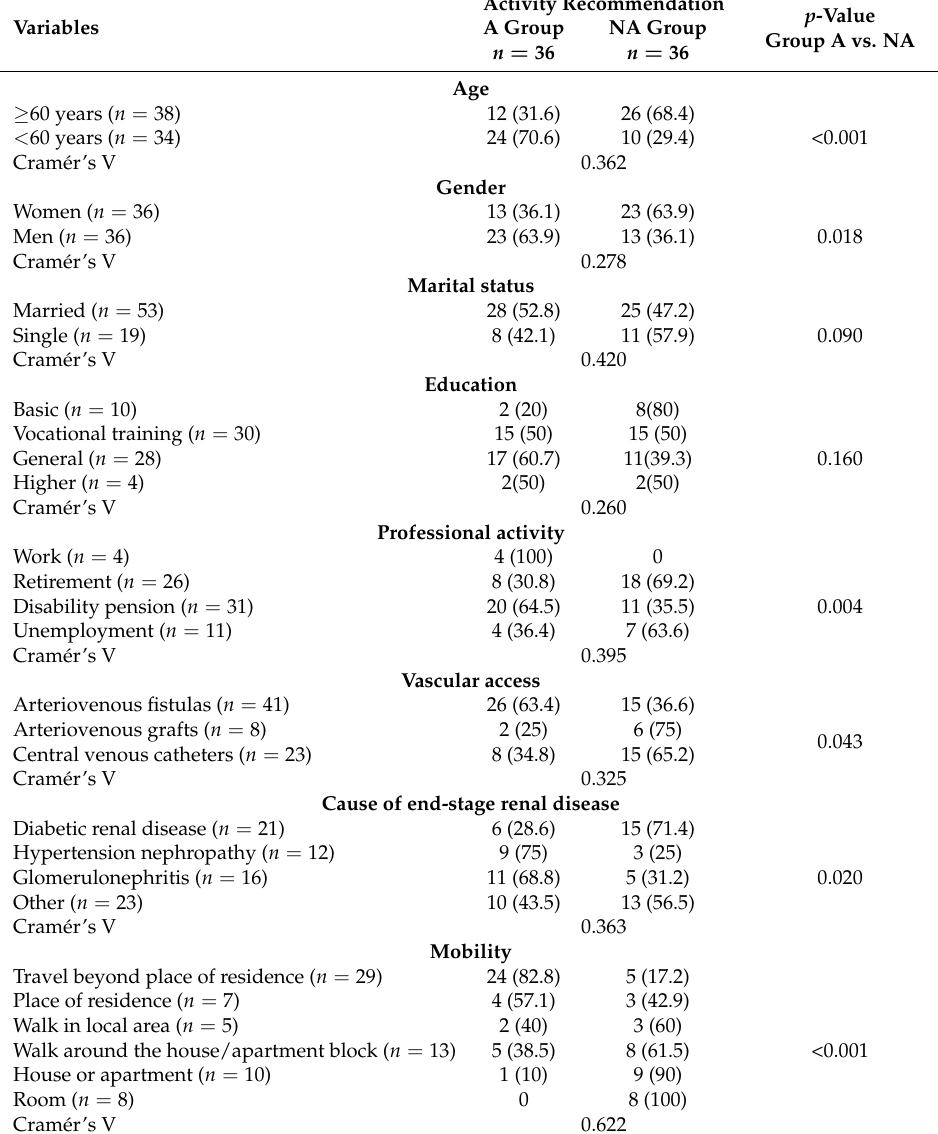
Table 2. Characteristicsofpatientsinrelationtoself-reportedadherencetophysicalactivityrecommendations.